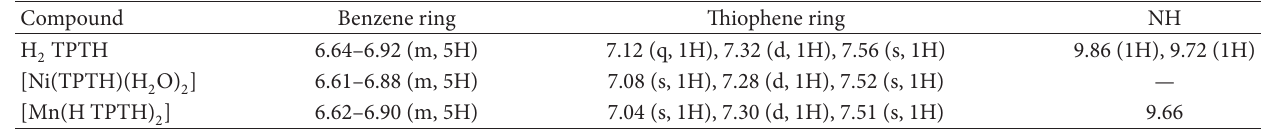
TPTH and the complexes ( 2